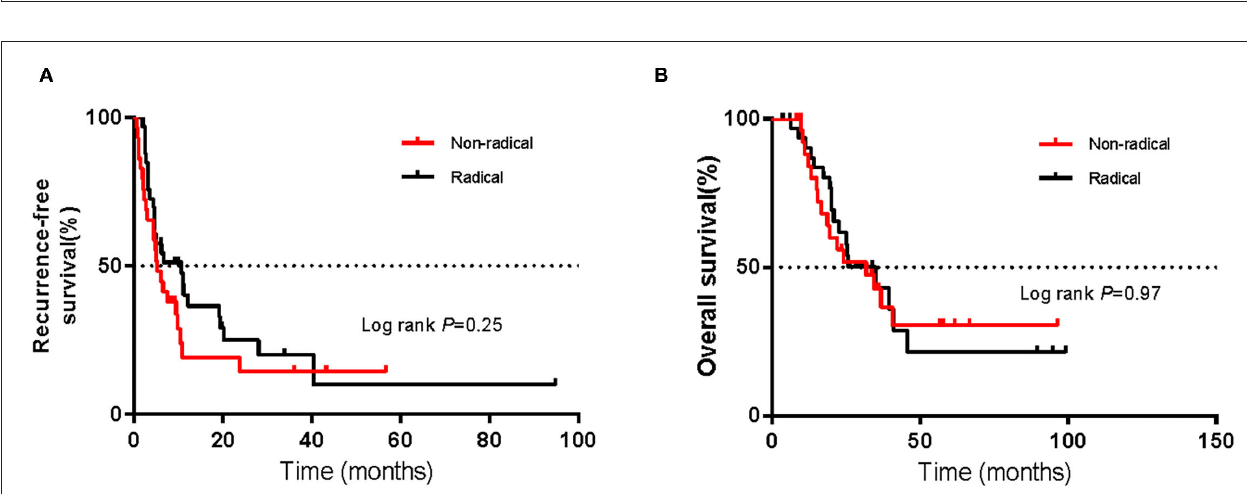
( Table 2 ). Given the possibility of effects of possible